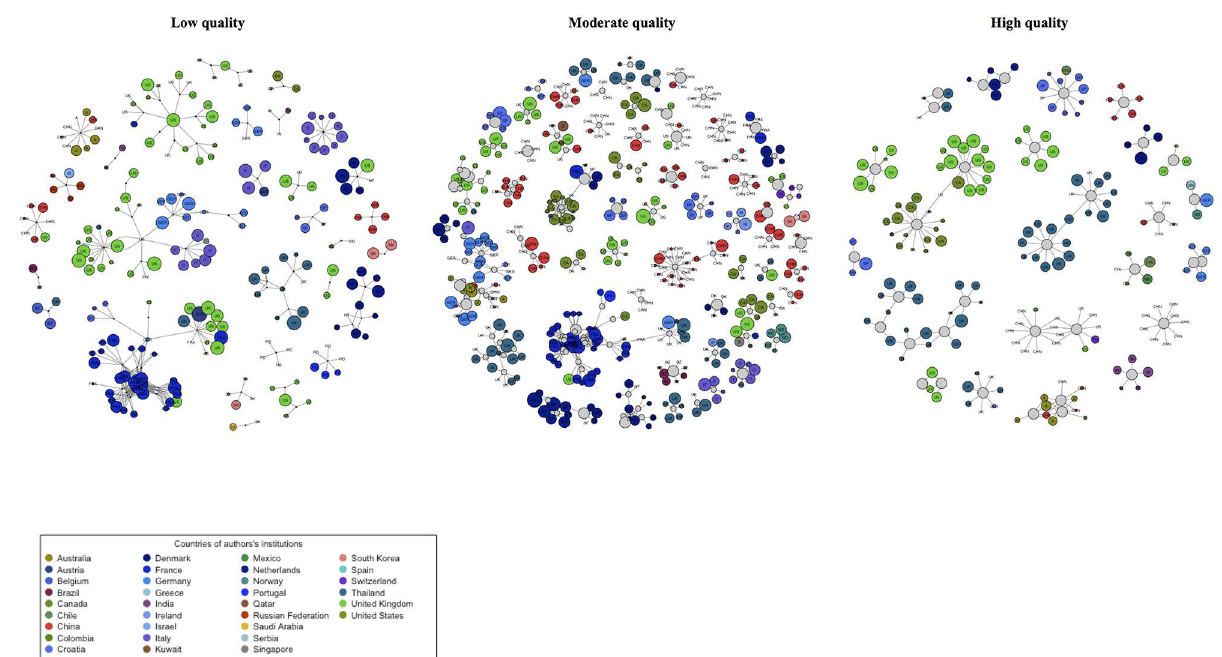
Fig 2. Author-paper affiliation subnetworks based on methodological quality of the reviews. Nodes that represent authors are colored and labeledbasedon their institution’scountry. Grey nodes represent the SRs and MAs on psoriasiswhich were finally included. Node size is proportional to the author’s H-indexor AMSTAR score respectively. Edges connect both types of nodes, thus every author and their collaborators are connectedto the shared publication.